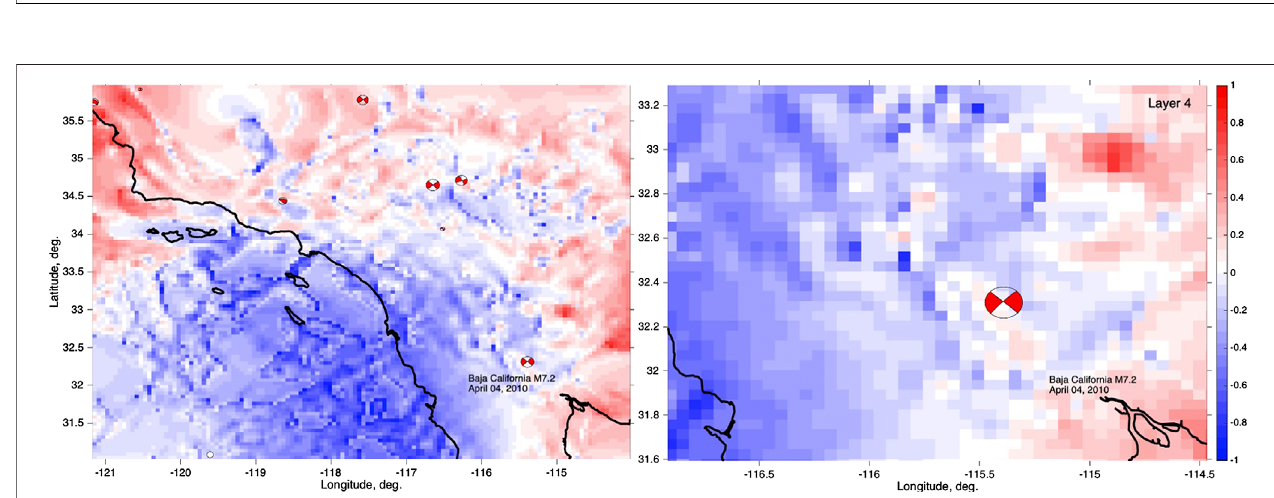
FIGURE8| Shearstrainmappedinmiddlecrustallayer2correspondingtoMarch15,April1,andApril15,2010.Theelevatedstrainisgivenascoloredimagemap, with individual colorscales shown in each panel. Underlying grayscale corresponds to initial normalized damage. Black diamond shows the epicenter of the Baja California M7.2 shock.